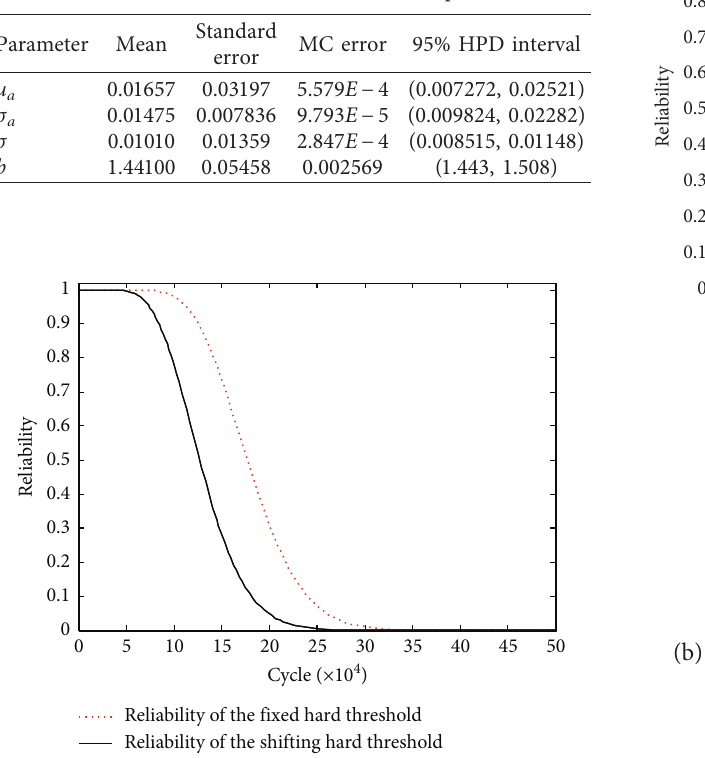
Table 1: Estimation results of the unknown parameters.